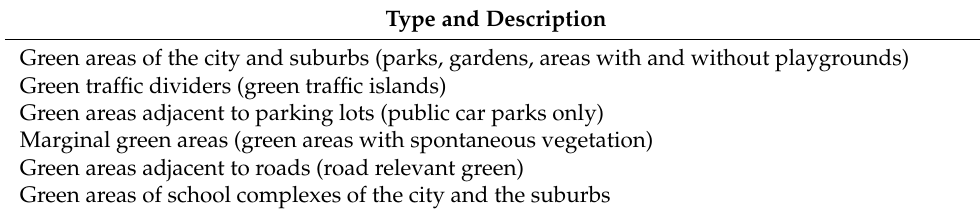
Table 3. List of the types of UOS within the Municipality of Latina. Type and Description Green areas of the city and suburbs (parks, gardens, areas with and without playgrounds) Green traffic dividers (green traffic islands) Green areas adjacent to parking lots (public car parks only) Marginal green areas (green areas with spontaneous vegetation) Green areas adjacent to roads (road relevant green) Green areas of school complexes of the city and the